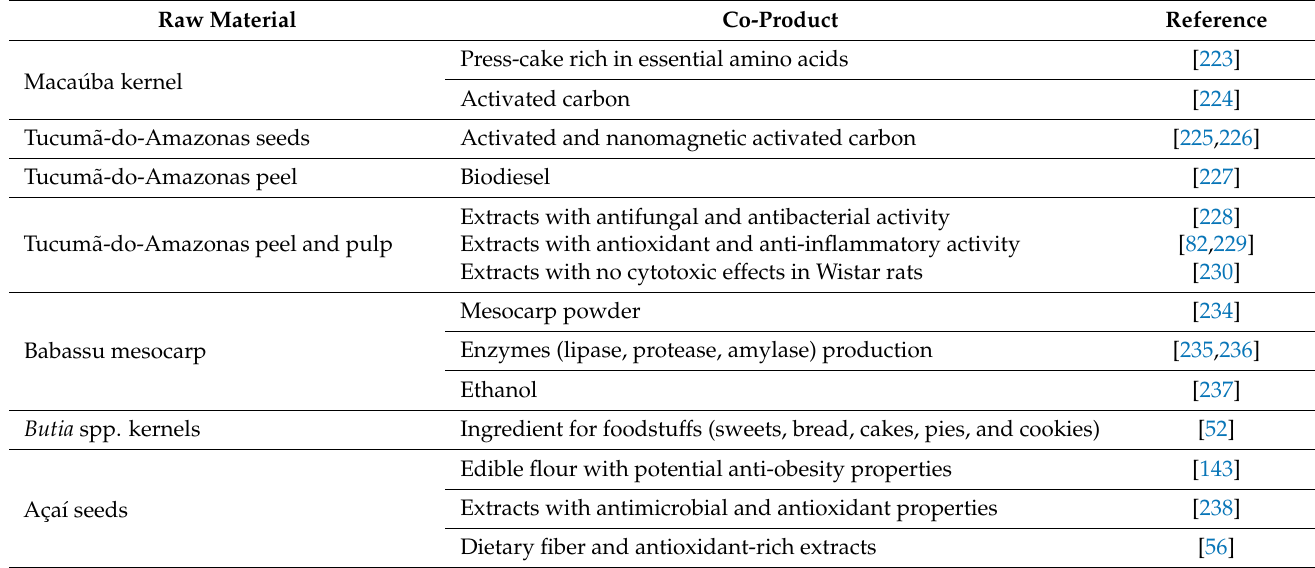
Table 7. Co-products from the oil extraction of Arecaceae palm